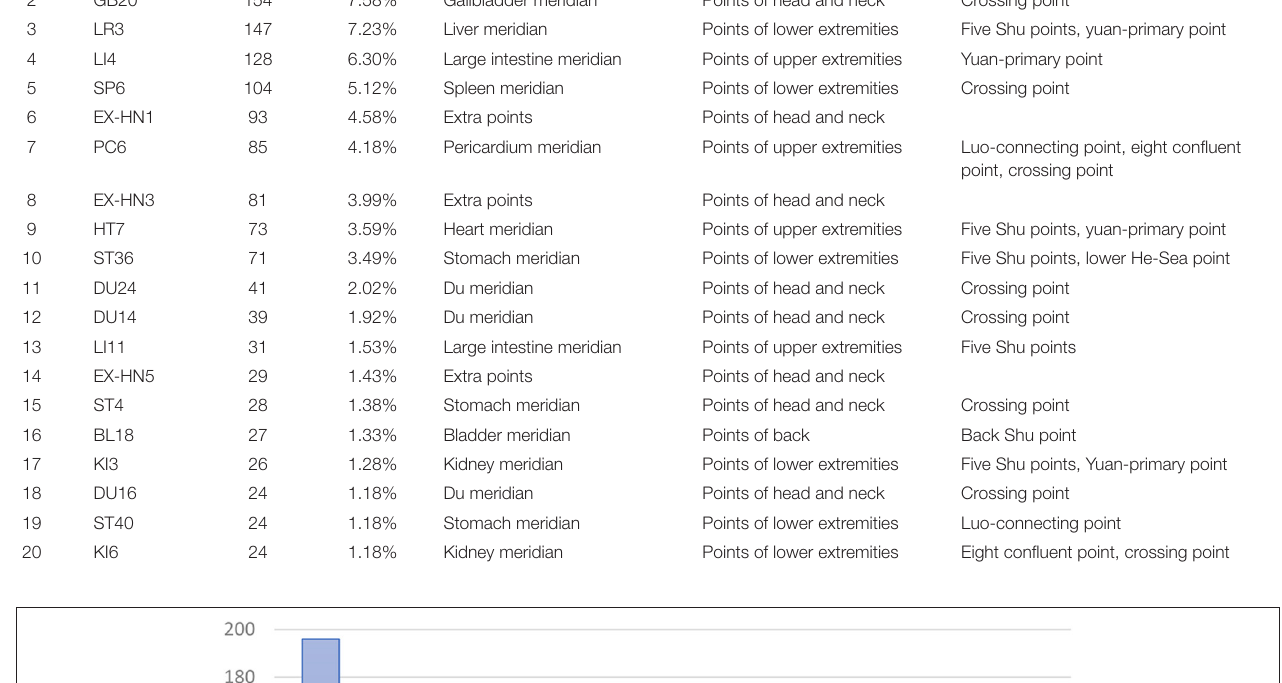
TABLE 1 | Frequency of acupoint application for TD treatment.